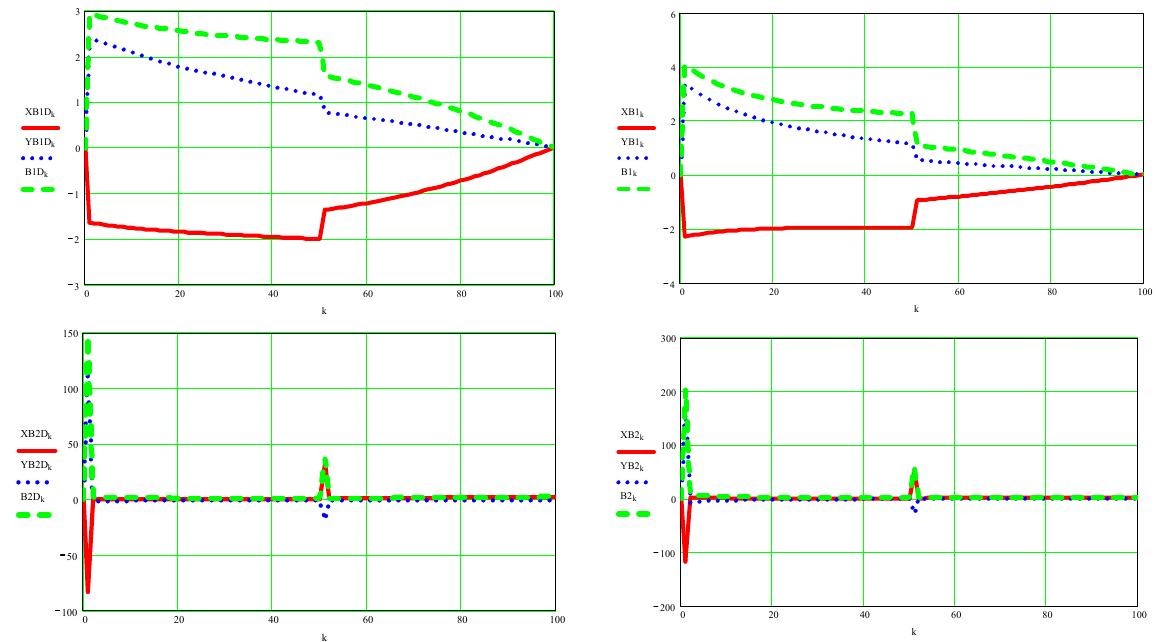
Figure A11. Here are represented the velocities of point B in their scalar coordinates (with red for the x-axis and with blue for the y-axis) and in absolute value (with green), dynamic on the left and kinematic on the right, at the top, and below are similarly represented the accelerations corre- sponding to the same point B.